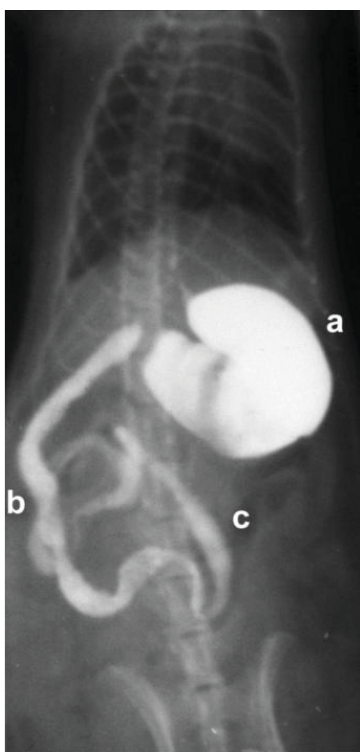
Figure 1. Contrast facial radiographs from a control rat immediately after an administration of CM. CM is present in the stomach (a), duodenum (b), and part of jejunum